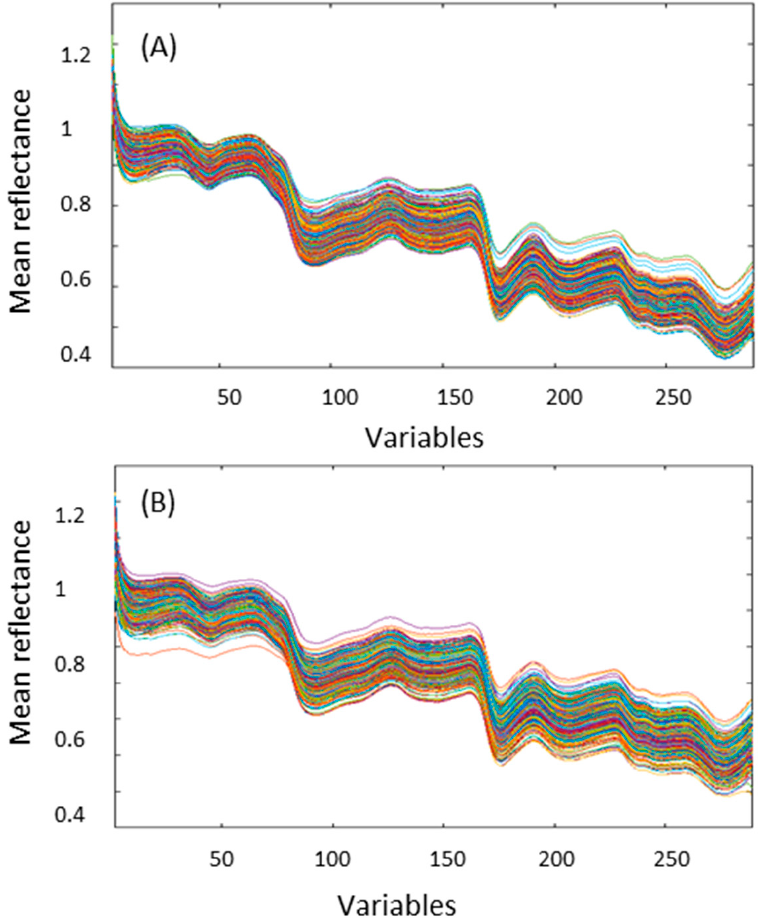
Figure 2. Raw NIR spectra of E − (WE) seed ( A ) and E+ (NEA12 endophyte-infected) seed ( B ). The variables represent 288 wavelengths acquired in the spectral range (1000–2500 nm).